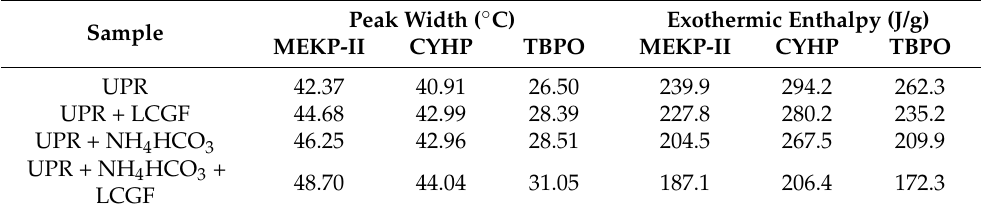
Table 5. Different peak widths and different curing exothermic enthalpies of different samples with the presence of different initiators and the same